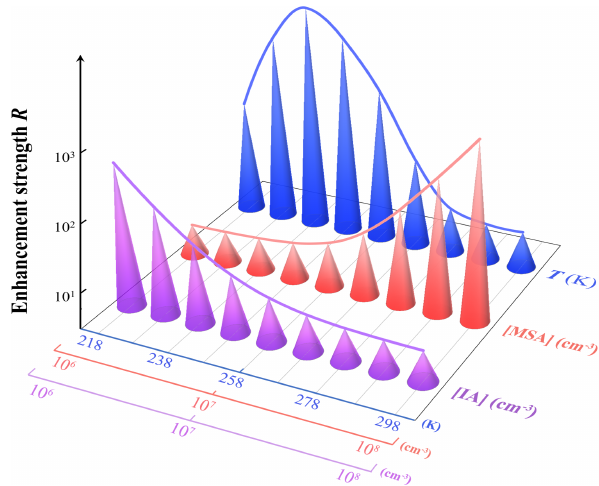
Figure 3. Simulated cluster formation rates J (cm − 3 s − 1 ) as a function of iodic acid concentration [IA], with different concentra- tions of methanesulfonic acid [MSA] of 10 6 (blue), 10 7 (yellow), 10 8 (red), and 0molec.cm − 3 (purple, “pure-IA”), at T = 278K, and CS = 2 . 0 × 10 − 3 s − 1 . The gray diamonds are the measured rate data from the CLOUD experiment at T = 283K (He et al., 2021).